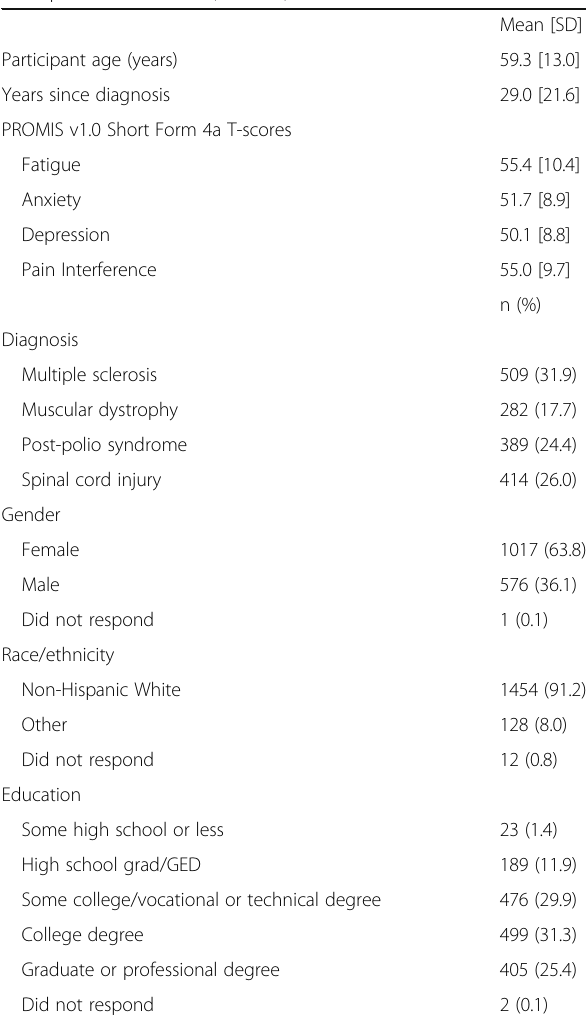
Table 1 Participant Characteristics Participant Characteristics ( n =